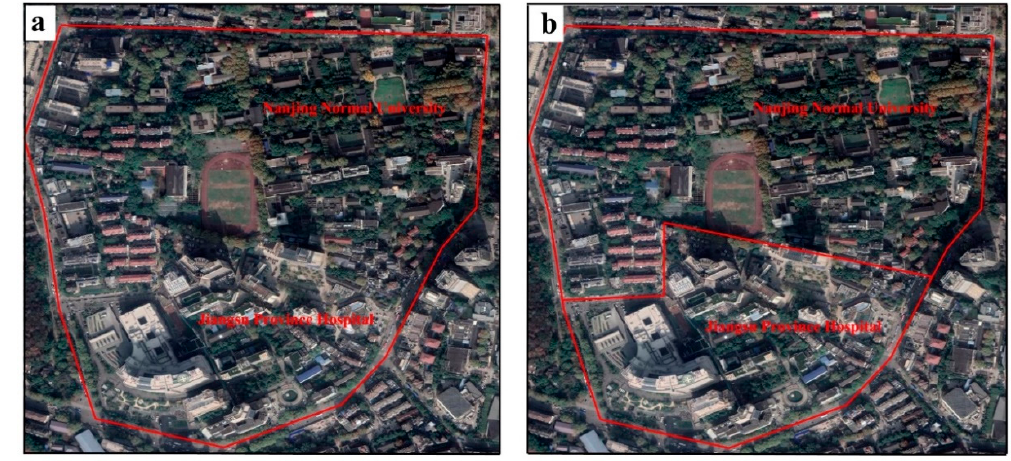
Figure 6. ( a ) The parcel before editing. ( b ) The parcel after editing.